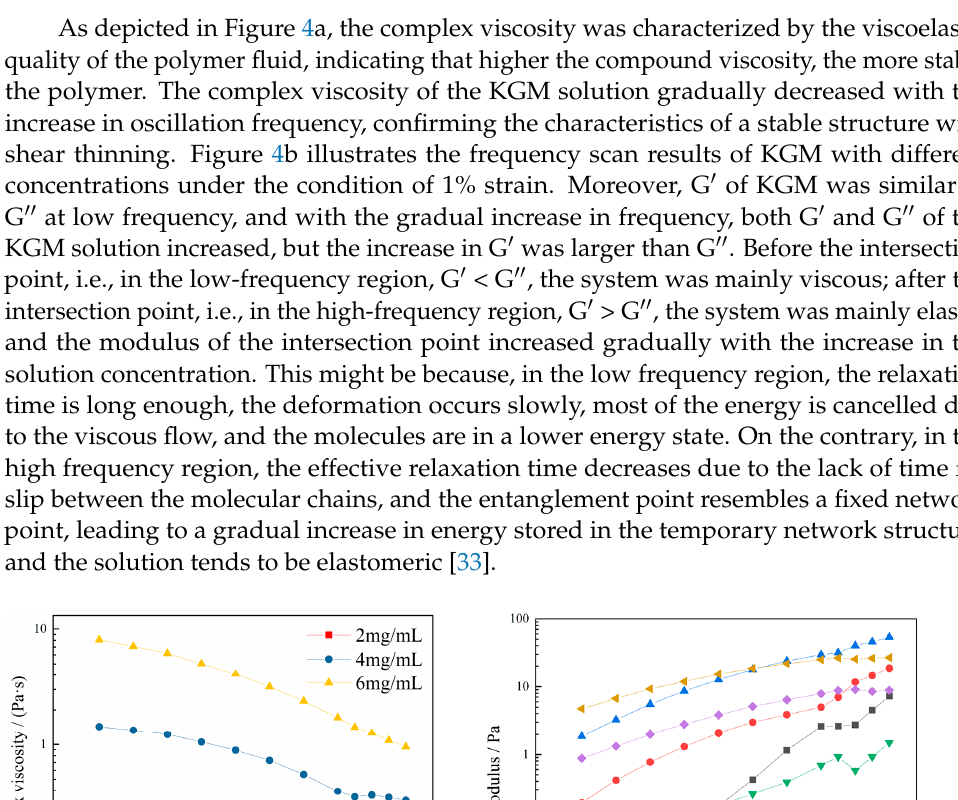
Figure 3. Effect of temperature on viscosity of KGM.